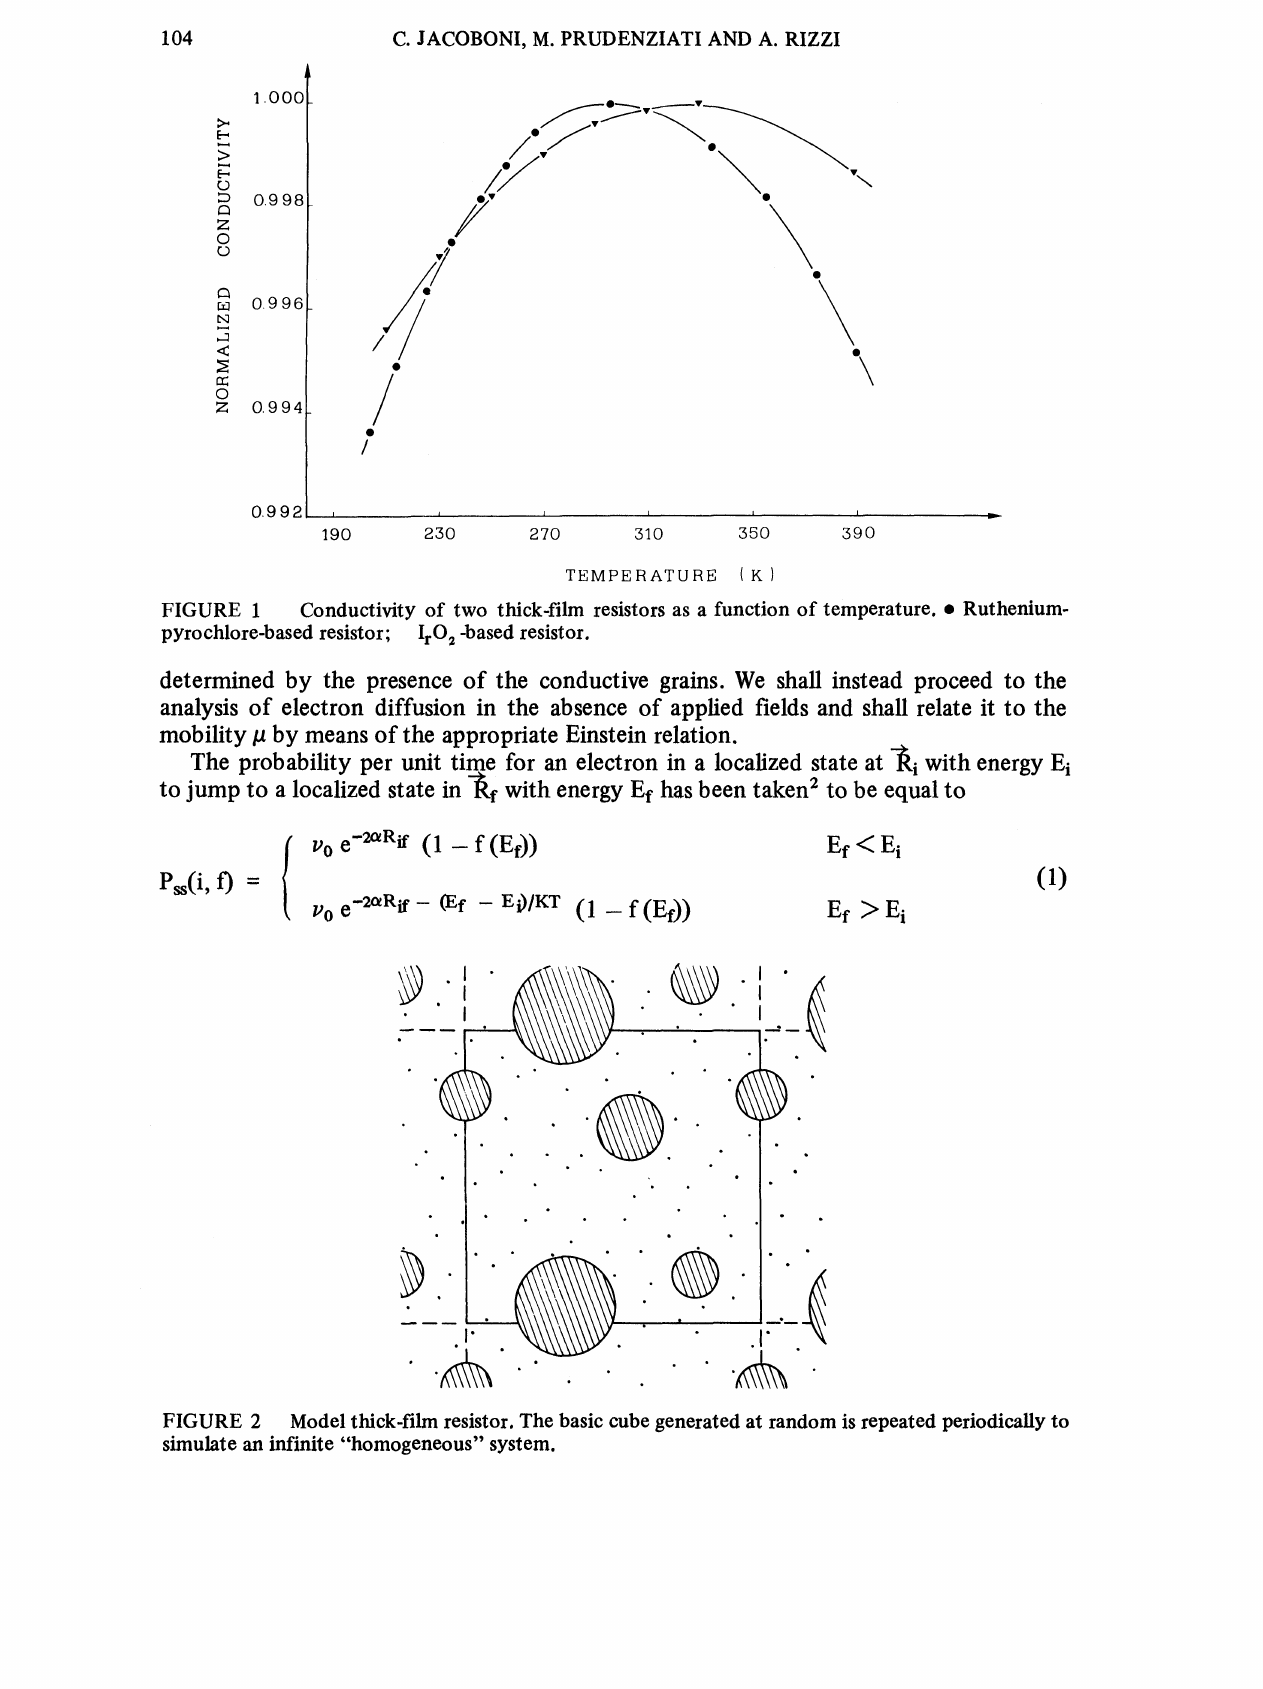
Model thick-film resistor. The basic cube generated at random is repeated periodically to simulate an infinite "homogeneous"